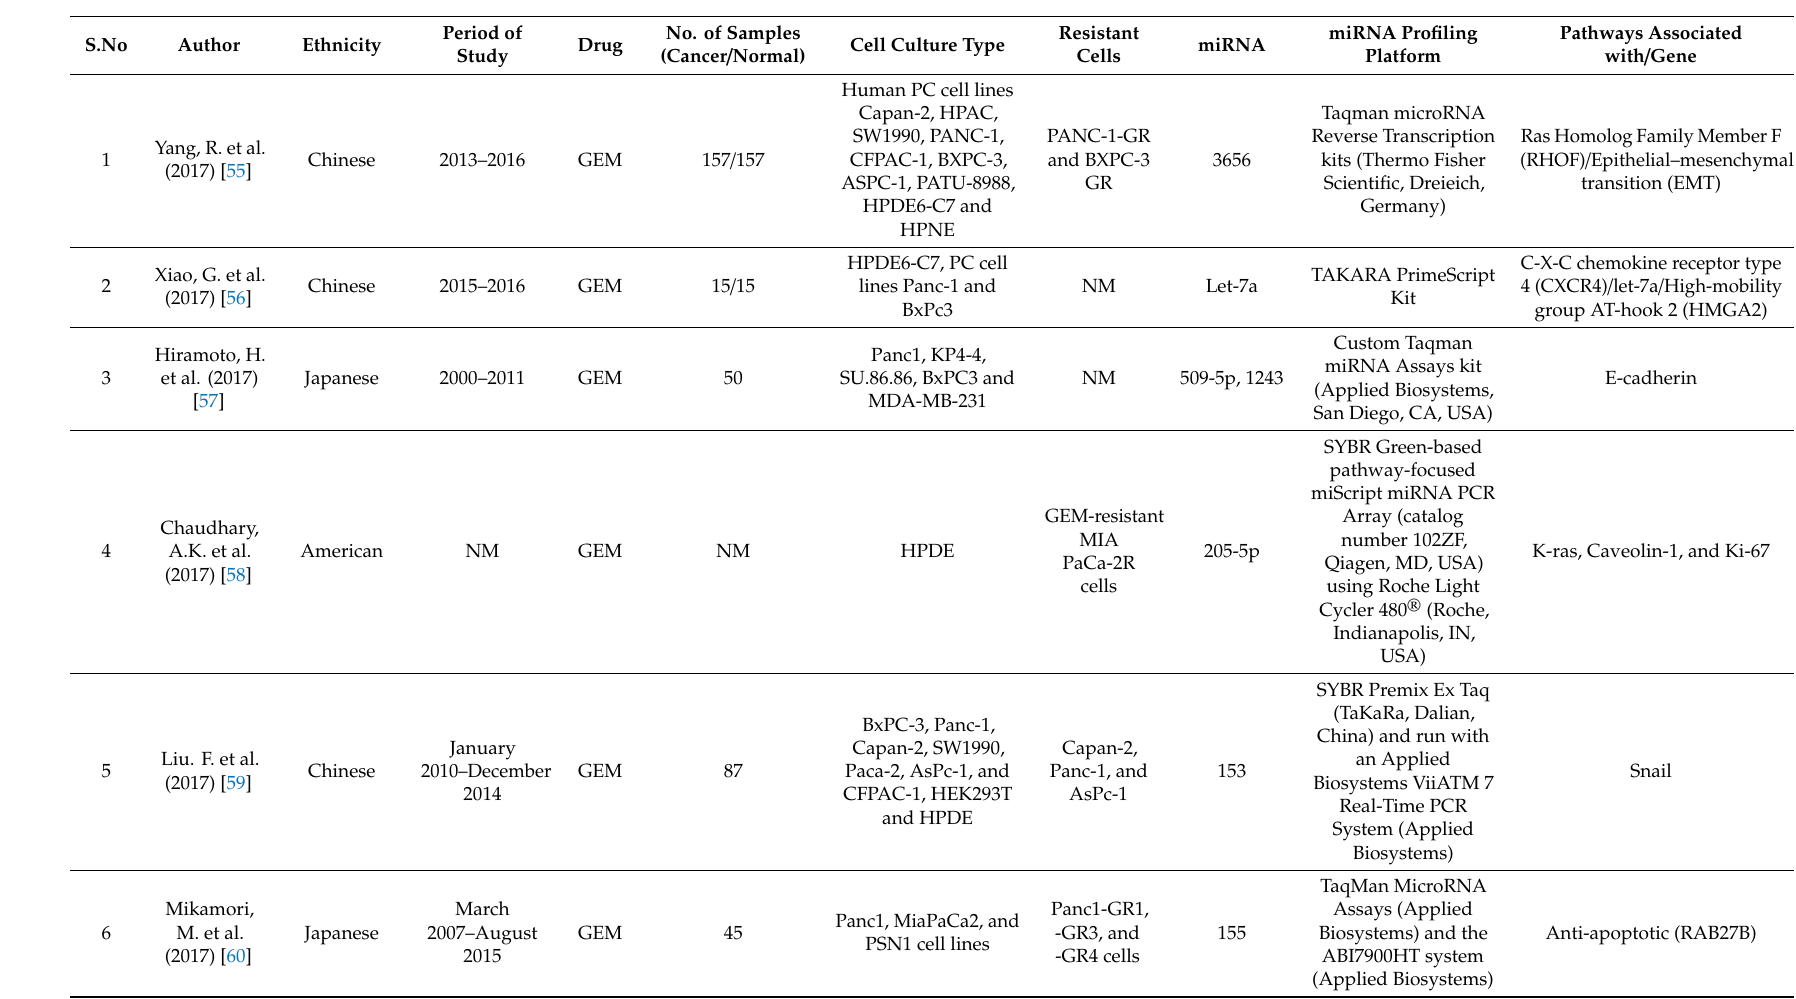
Table 1. Characteristics of 43 included